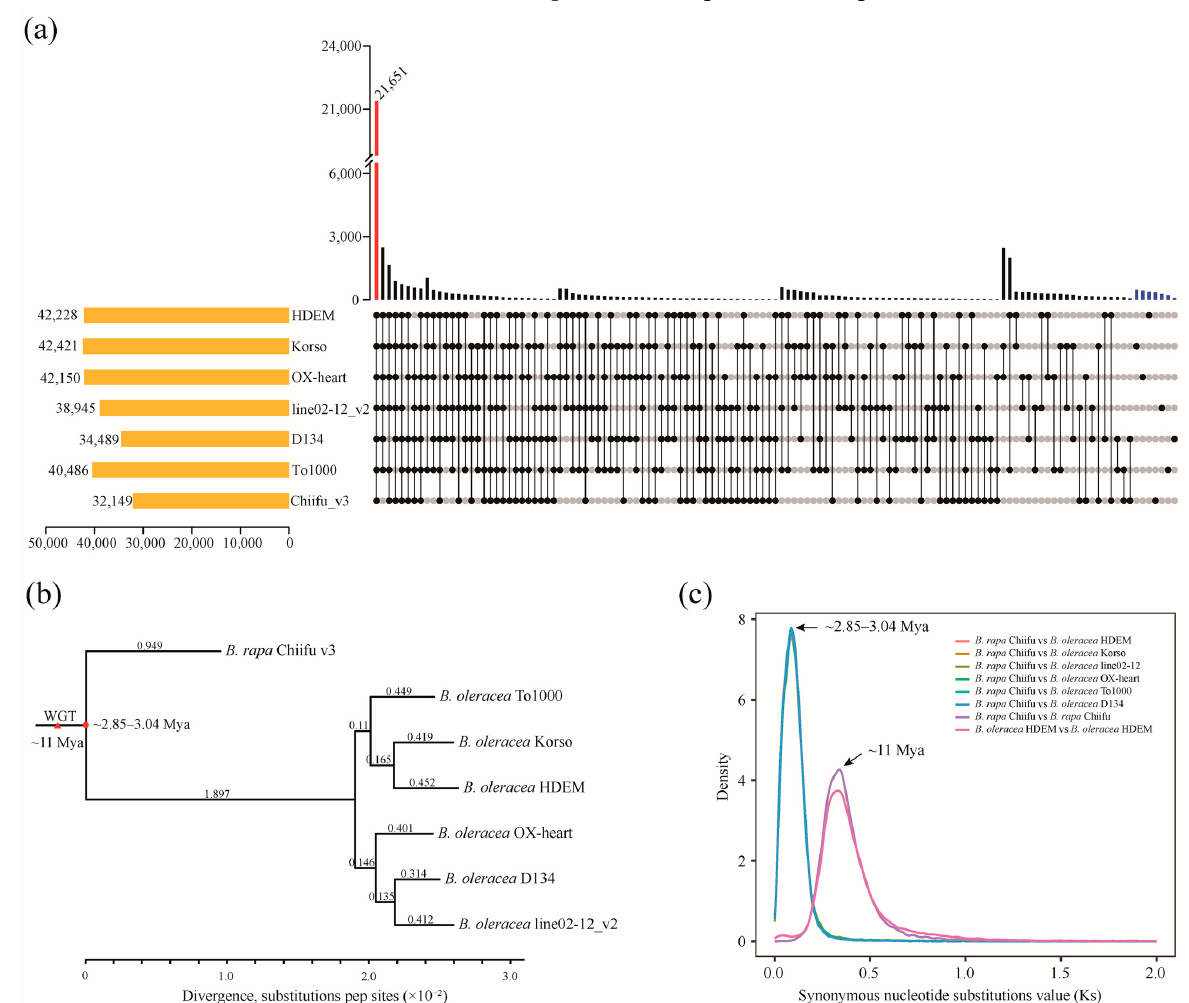
Figure 3. Evolutionary analysis of B. oleracea . ( a ) An upset diagram shows unique and shared gene families between six B. oleracea and B. rapa Chiifu genomes. The number, along with the histograms, show the clusters in each accession. ( b ) Single-copy gene-based phylogenetic relationship for 6 B. oleracea accessions with Chiifu as an outgroup. A whole-genome triplication (WGT) event of Brassica species is noted by a red triangle. The point of the differentiation time of B. rapa (AA) and B. oleracea (CC) is marked by a red solid circle (Mya, million years ago). ( c ) Density plots of synonymous sub- stitutions (Ks) of Chiifu and other plant species are represented by columns of different colors. The arrows marked at the peak of Ks, from left to right, represent the differentiation time of B. rapa (AA) and B. oleracea (CC) and the time of Brassica -specific WGT event, respectively.